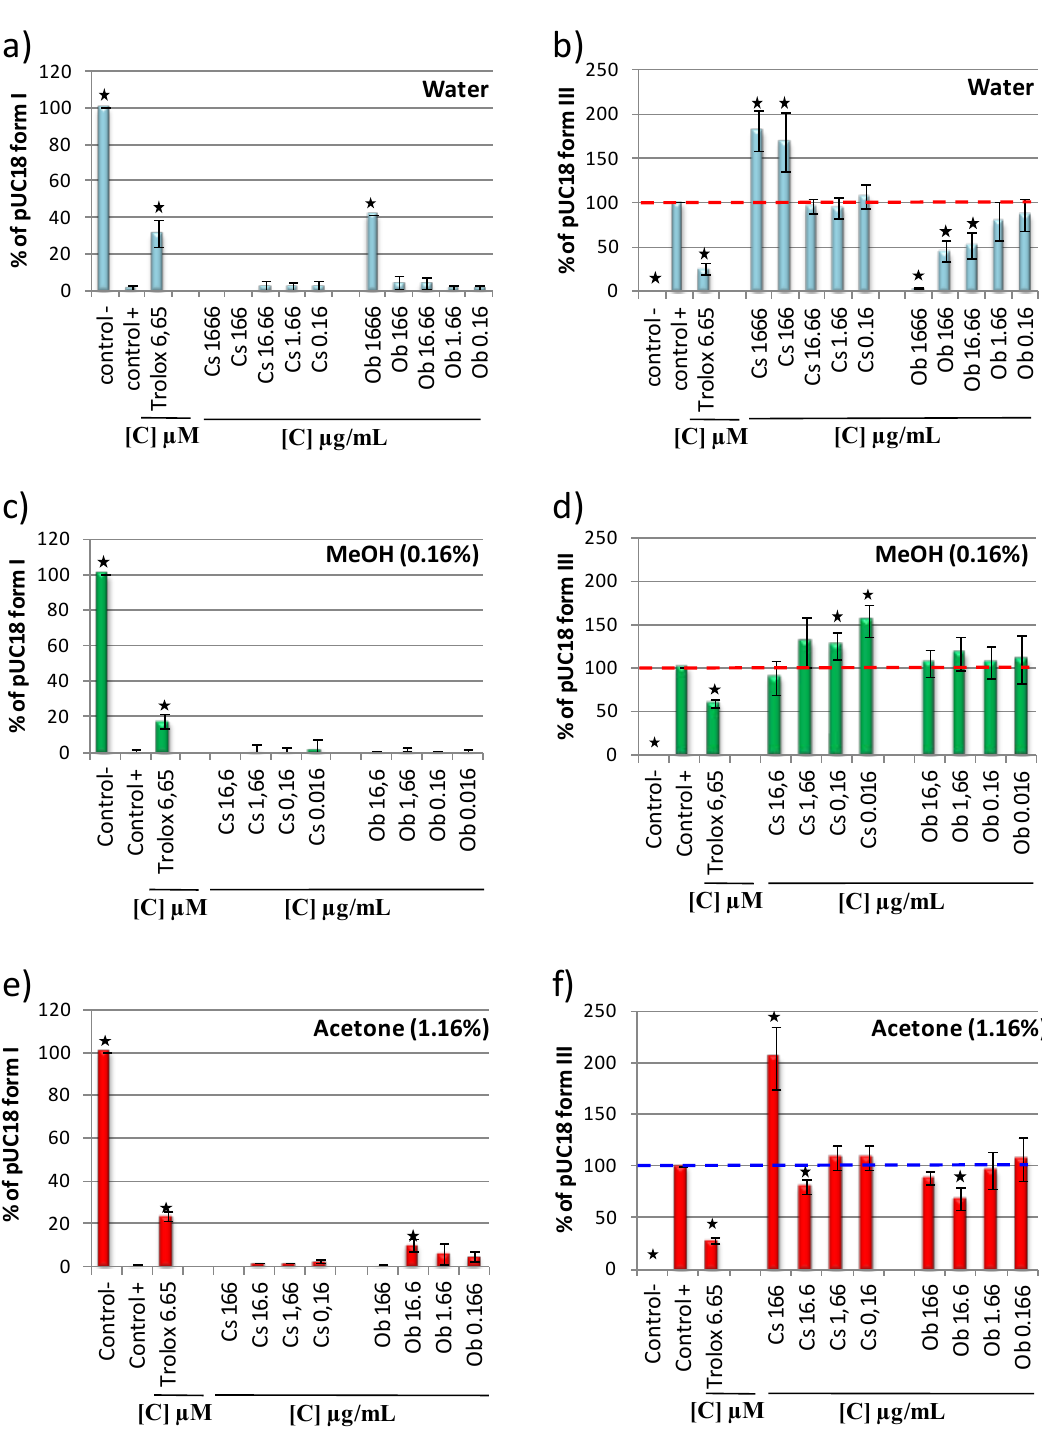
Figure 5. Quantification of pUC18 aqueous Camelia sinensis (Cs) and Oenocarpus bataua (Ob) extract ( a ) form I protection and ( b ) form III formation; Quantification of pUC18 methanolic Camelia sinensis (Cs) and Oenocarpus bataua (Ob) extract ( c ) form I protection and ( d ) form III formation; Quantification of pUC18 acetonic Camelia sinensis (Cs) and Oenocarpus bataua (Ob) extract ( e ) form I protection and ( f ) form III formation. Asterisks indicate significant differences between control+ and the other assays at p < 0.05. Data are representative of three assays, error bars represent